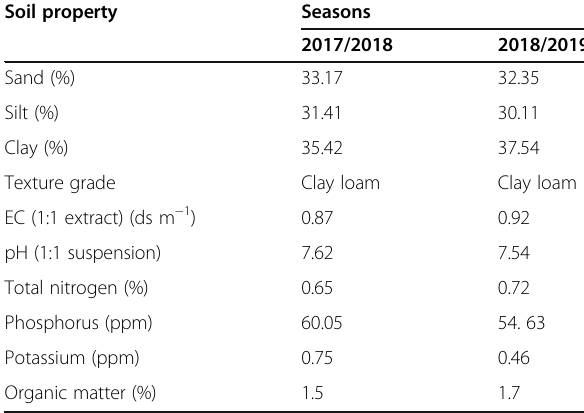
Table 2 Some physical and chemical properties of representative soil samples of the experimental site before sowing for 2017/2018 and 2018/2019